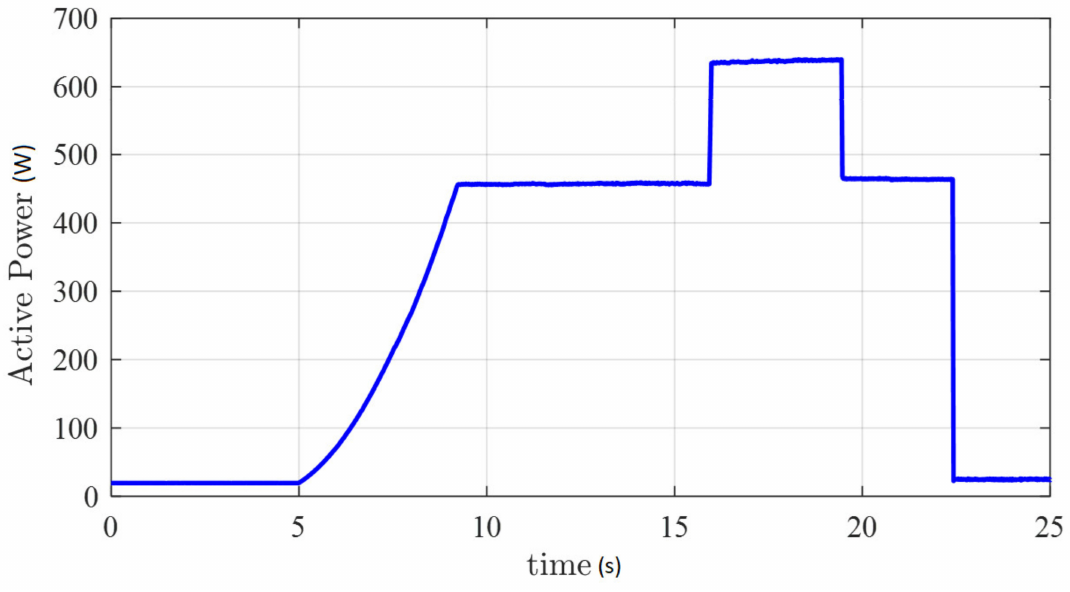
Figure 11. Active power supplied by the grid-forming